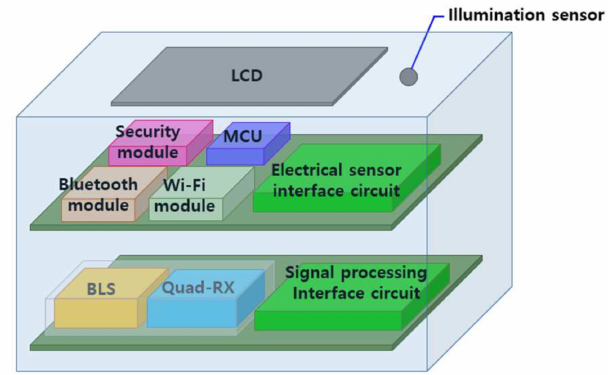
Figure 1. Schematic diagram of the sensing